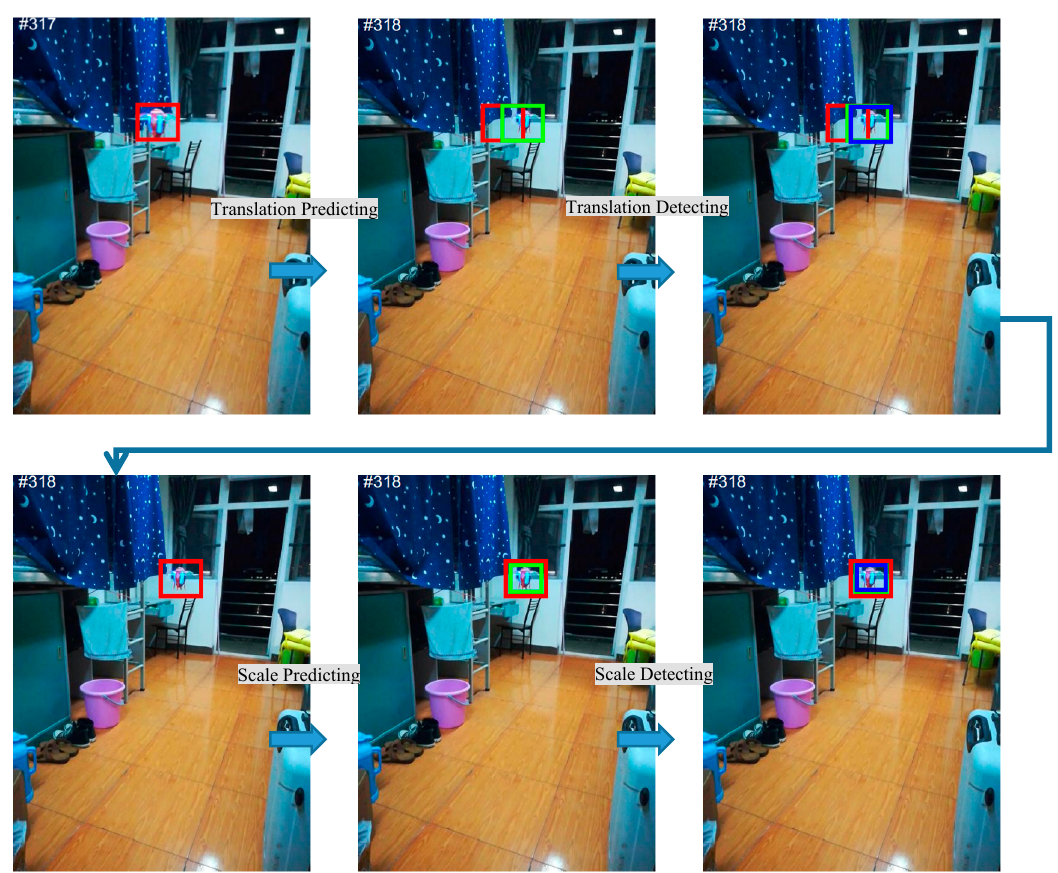
Figure 3. Visualization of the separate translation and scale prediction and detection on the video sequence of UAV. The previous position and scale are indicated by red bounding box, and the predicted position and scale are denoted in green, and the detected position and scale are shown with blue bounding